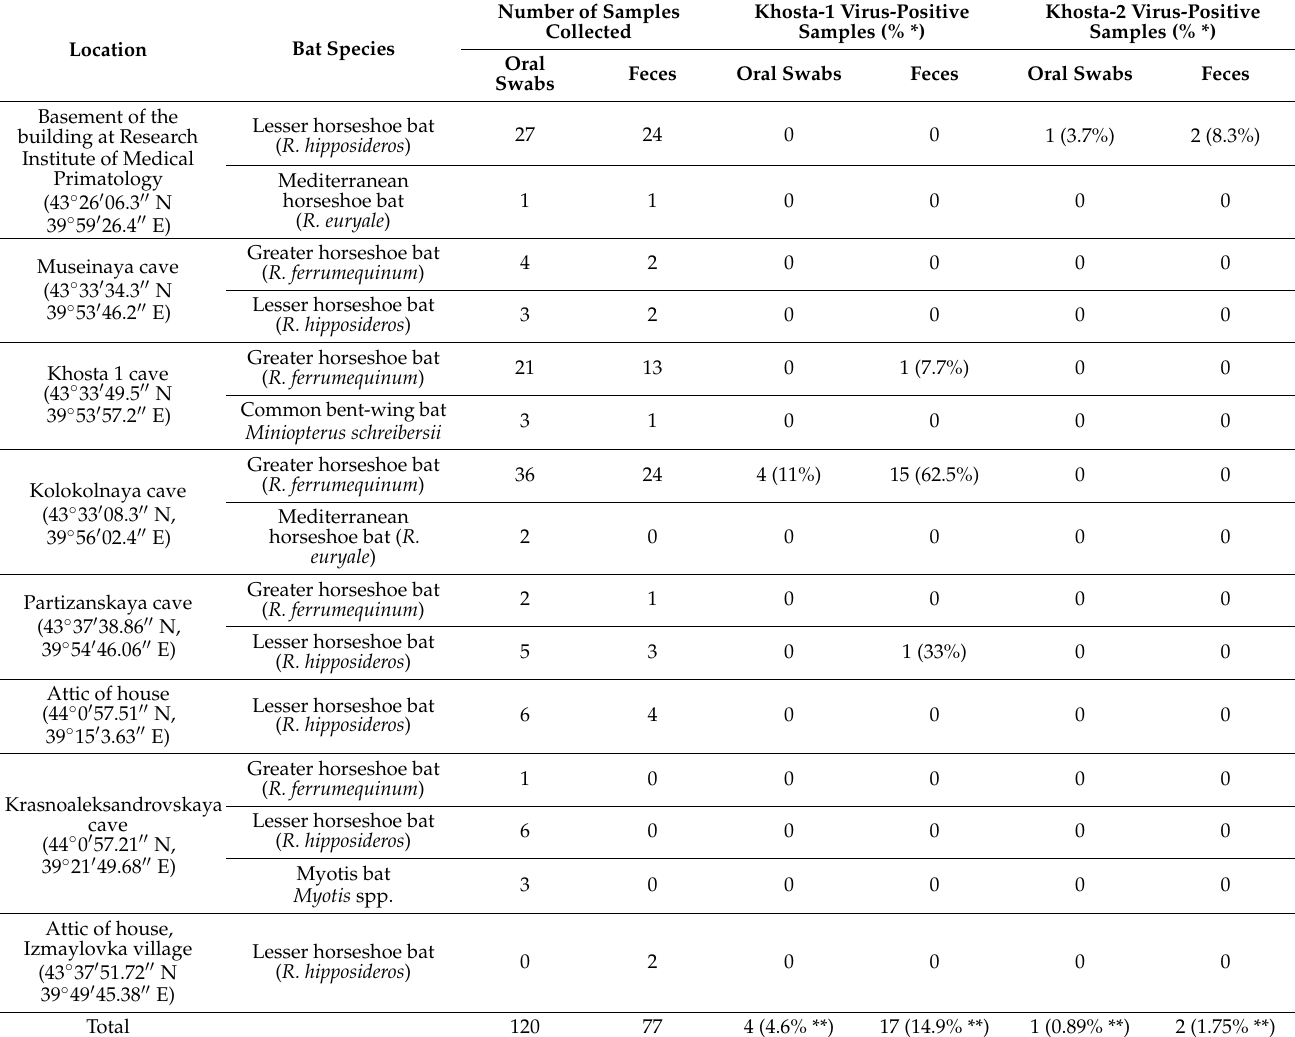
Table 1. The bat samples collected and results of RT-PCR testing for Khosta-1 and Khosta-2 viruses.